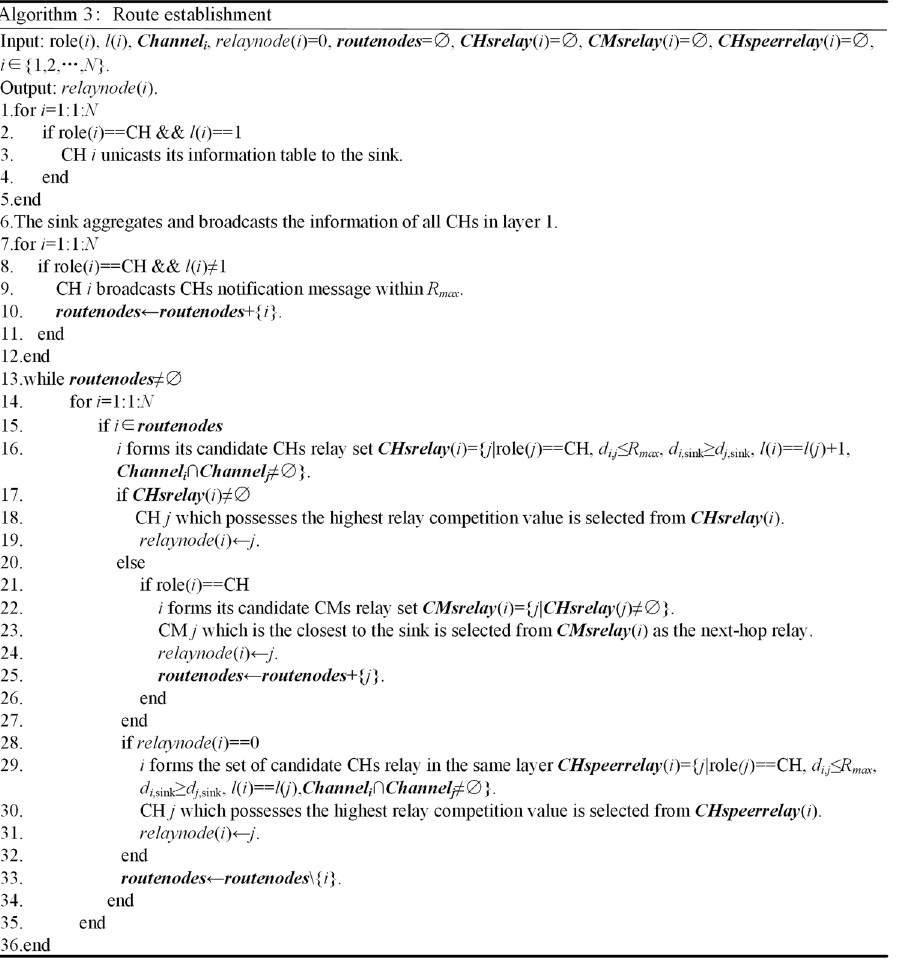
Figure 6. Pseudo code for route